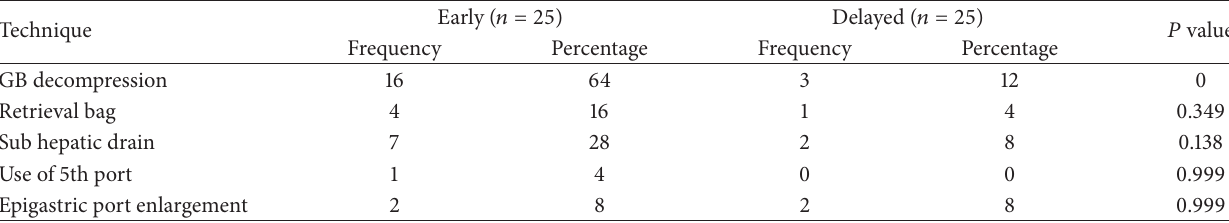
Table 2: Various modifications of technique in early and delayed Group.